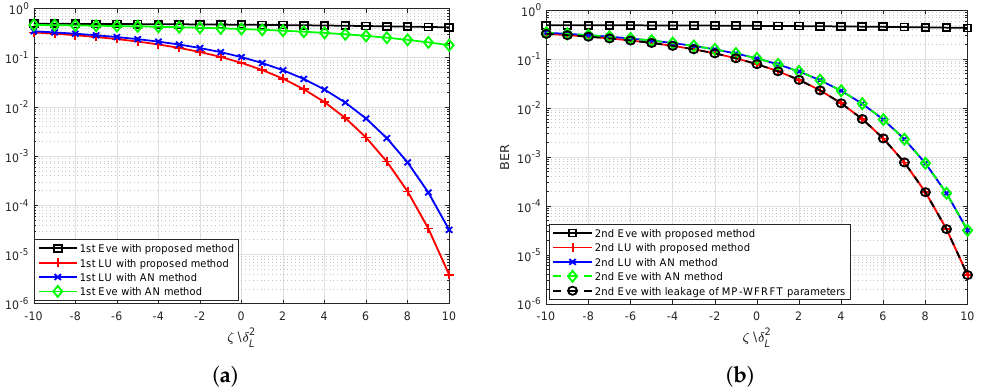
Figure 7. The bit error rate (BER) performance with independent LU versus the desired received power to noise ratio: ( a ) LU 1 and ( b ) LU 2.